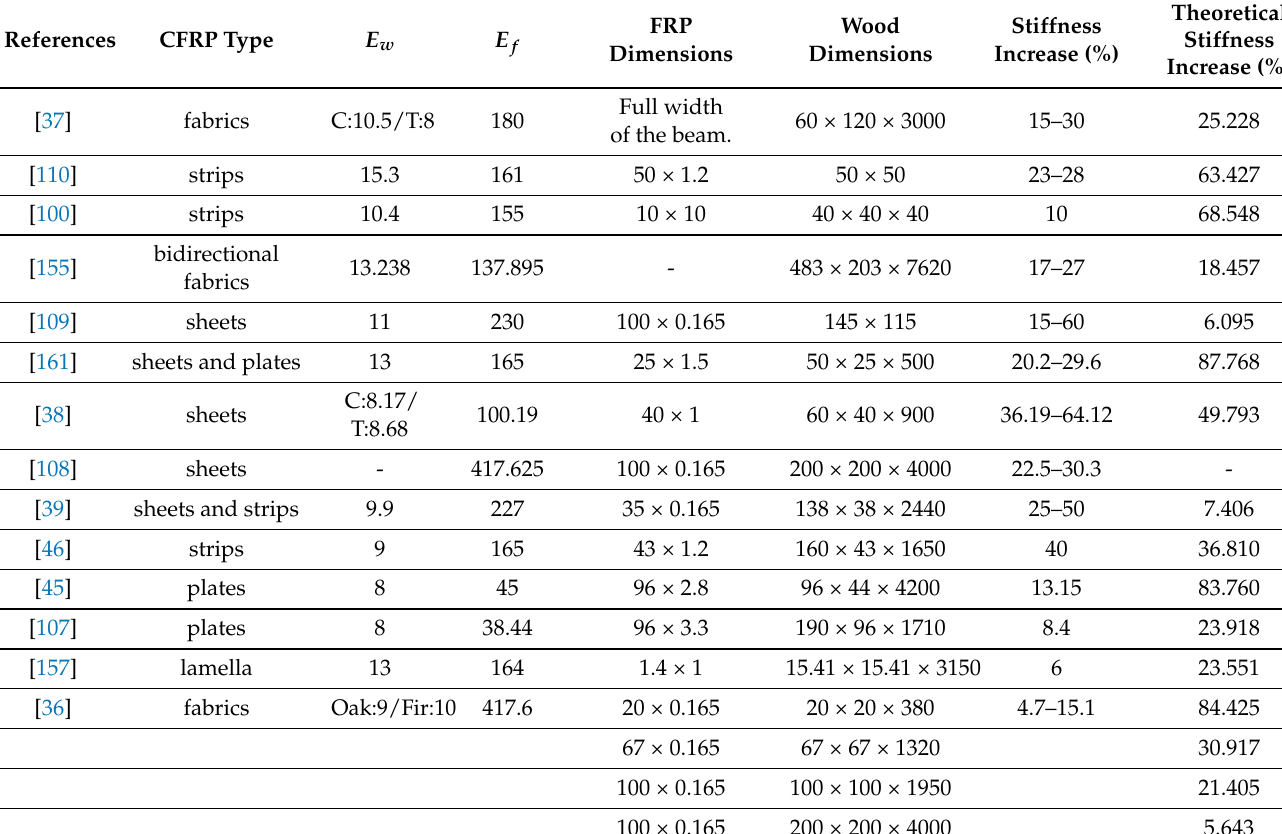
Table 3. The increase in stiffness in some studies versus the theoretical increase based on Euler-beam model. E w modulus of elasticity for wood (GPa); E f modulus of elasticity for CFRP (GPa); wood dimensions as height × width × length (mm); CFRP dimensions as width × thickness (mm); C and T stand for compression and tension,